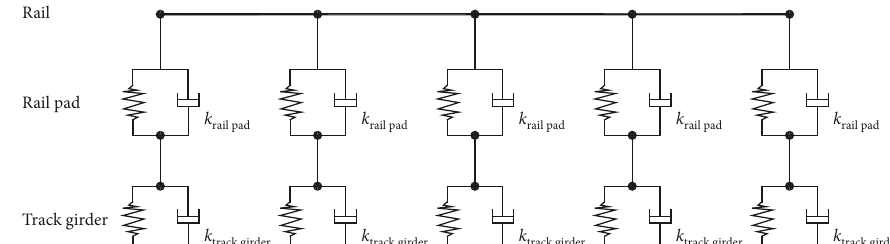
� rail pad stiffness (kN/mm). pad